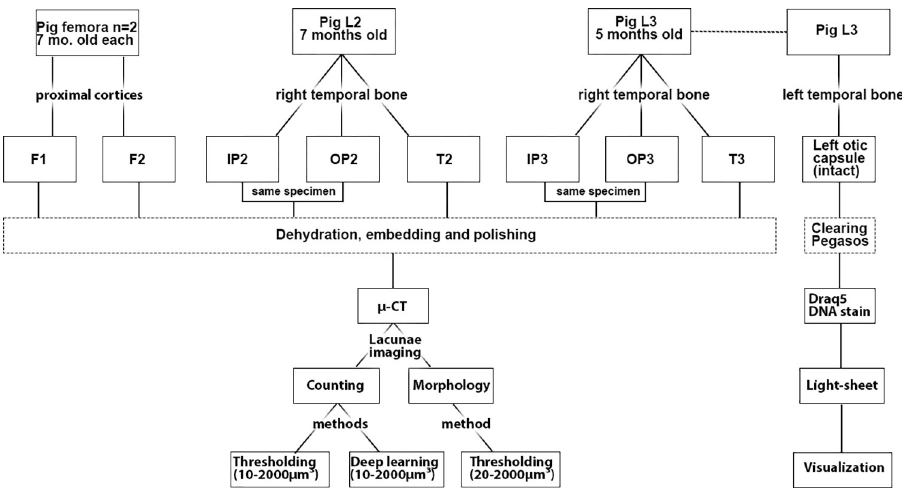
Fig 1. Flow chart of the pig samples in this study. The animal used is indicated at the top row, and the samples extracted from each animal are indicated in the second row. The third row shows sample preparation and then the flow of analyses after each